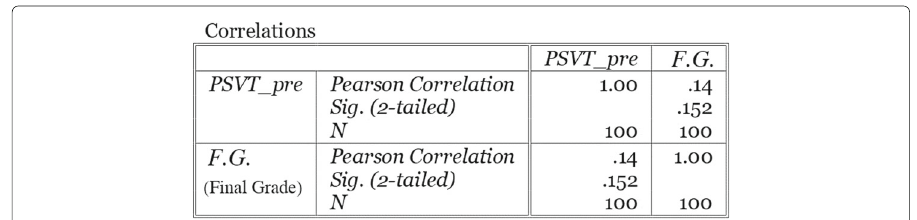
Fig. 19 Correlation between pre-test scores and final course